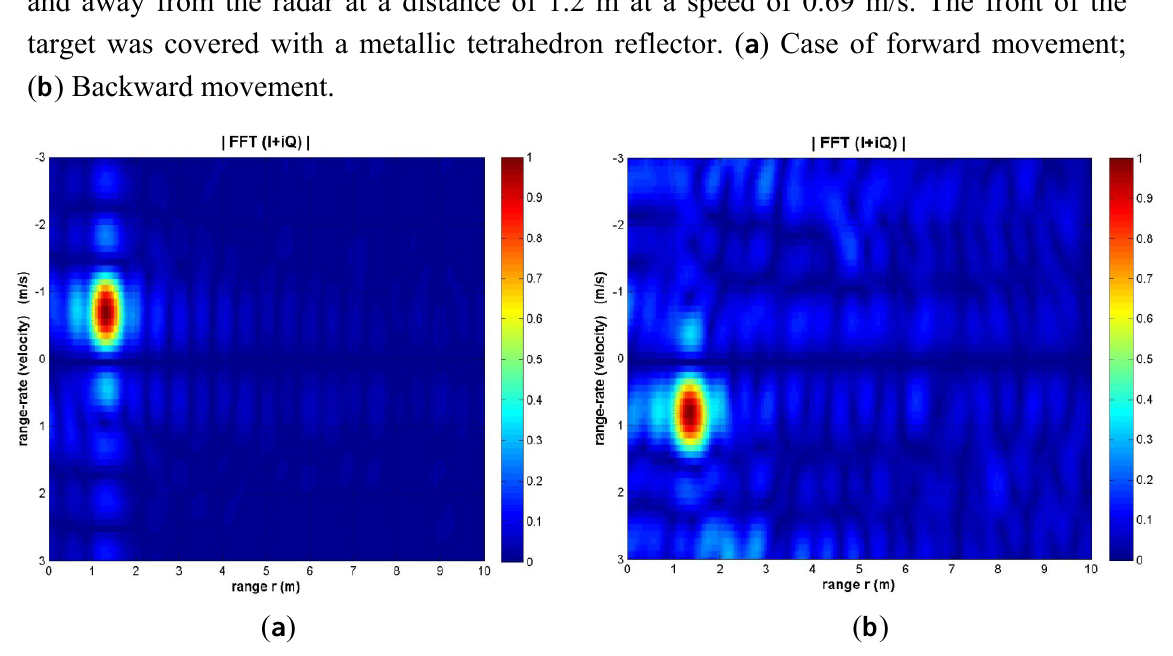
and away from the radar at a distance of 1.2 m at a speed of 0.69 m/s. The front of the target was covered with a metallic tetrahedron reflector. ( a ) Case of forward movement;